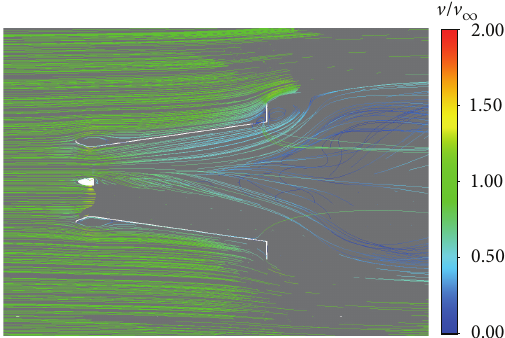
Figure 20: Streamline 𝜆 = 6.5 (Runner + C.D. (Type D)).